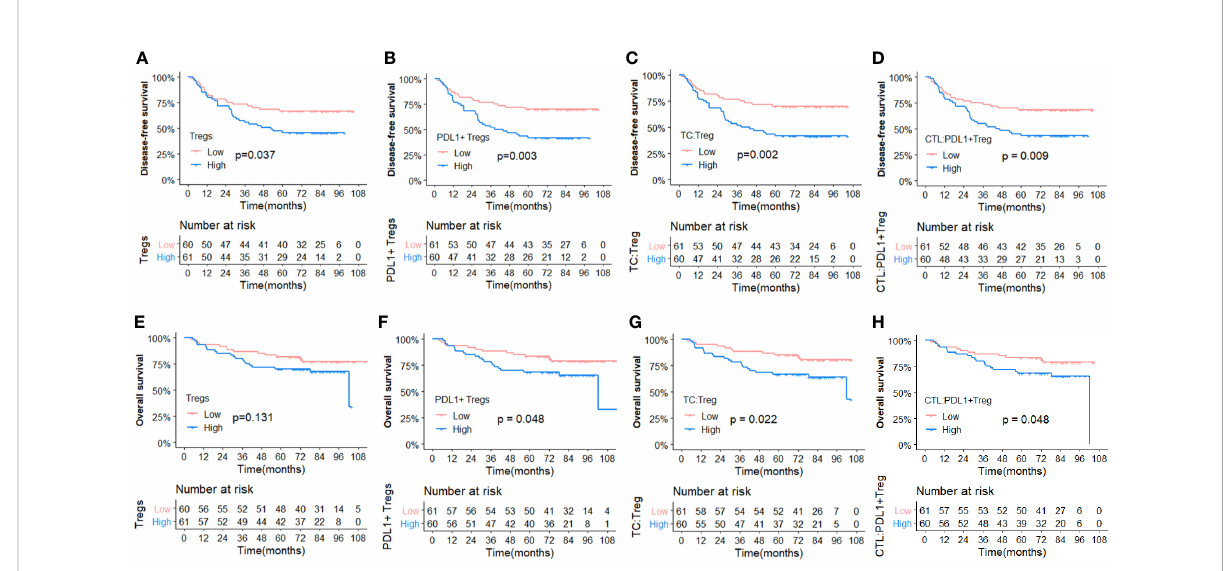
FIGURE 5 Comparisons of Kaplan-Meier survival curves between high and low in fi ltration density of TILs and Gcross function scores. (Upper panel) Disease free survival curves for Tregs (A) , PDL1+ Tregs (B) , G TC : Treg (C) and G CTL : PDL1+Treg (D) . (Lower panel) Overall survival curves for Tregs (E) , PDL1+ Tregs (F) , G TC : Treg (G) and G CTL : PDL1+Treg (H)